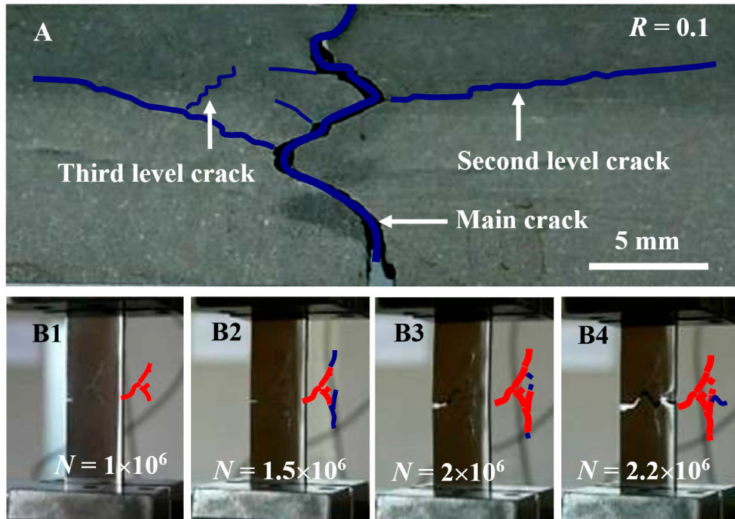
Figure 6. Extreme damage tolerance in tension–tension fatigue test. ( A ) Image of three-level fatigue cracks. ( B1 – B4 ) Crack propagations with cycle numbers N , in which the red and blue curves demonstrate the existing cracks in the former image and the extended cracks